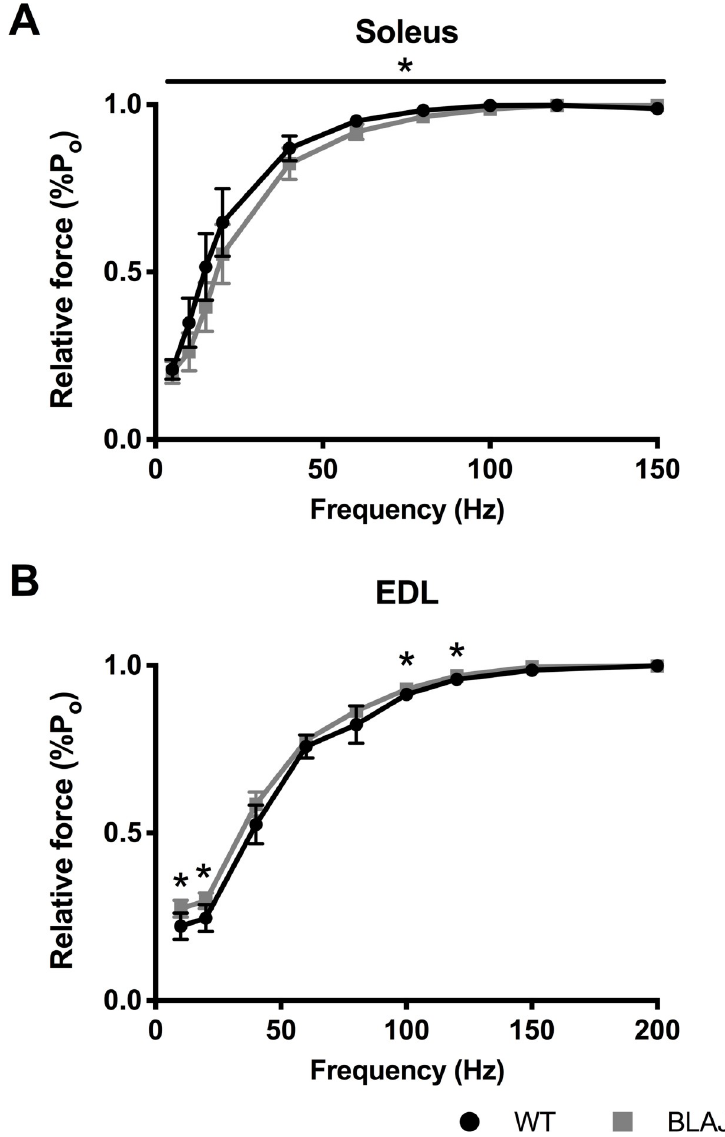
Fig 5. Normalised force-frequency relationship from WT and BLAJ mice aged 10 months. (A) soleus ( n = 9, 9) and (B) EDL ( n = 8, 9) muscles. � BLAJ significantly different to WT ( p s < 0.05). Data are presented as mean ± SD.